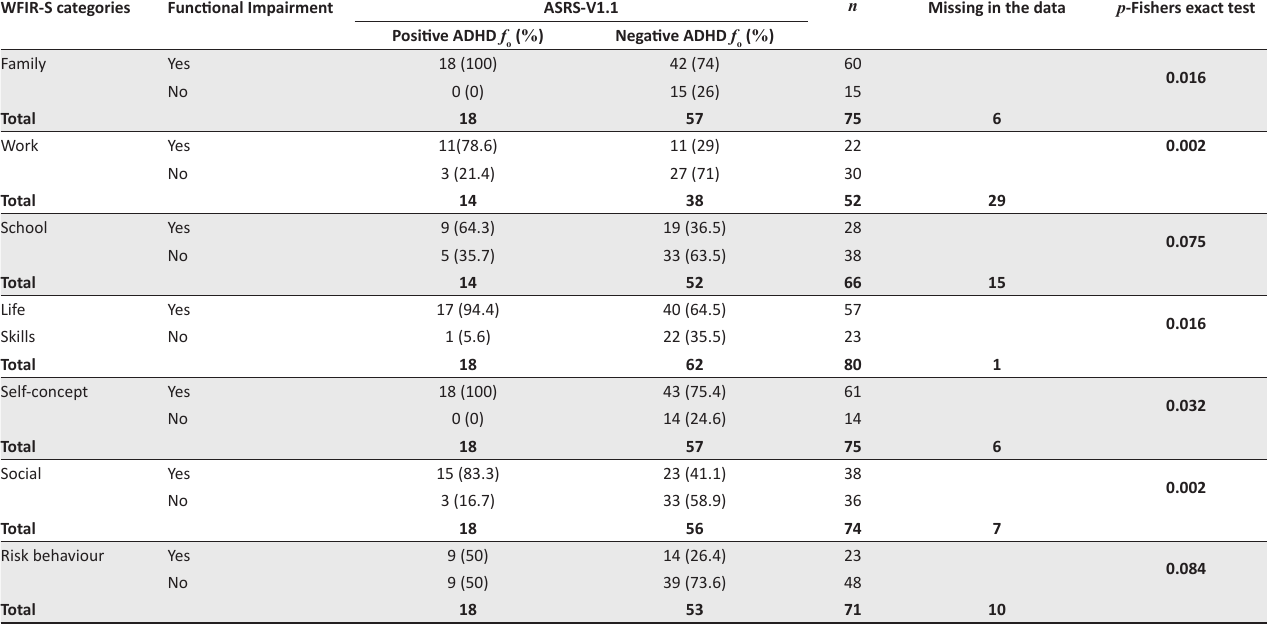
TABLE 2: Descriptive findings of ADHD subgroups for functional impairment and tests for significance between the two groups. WFIR-S